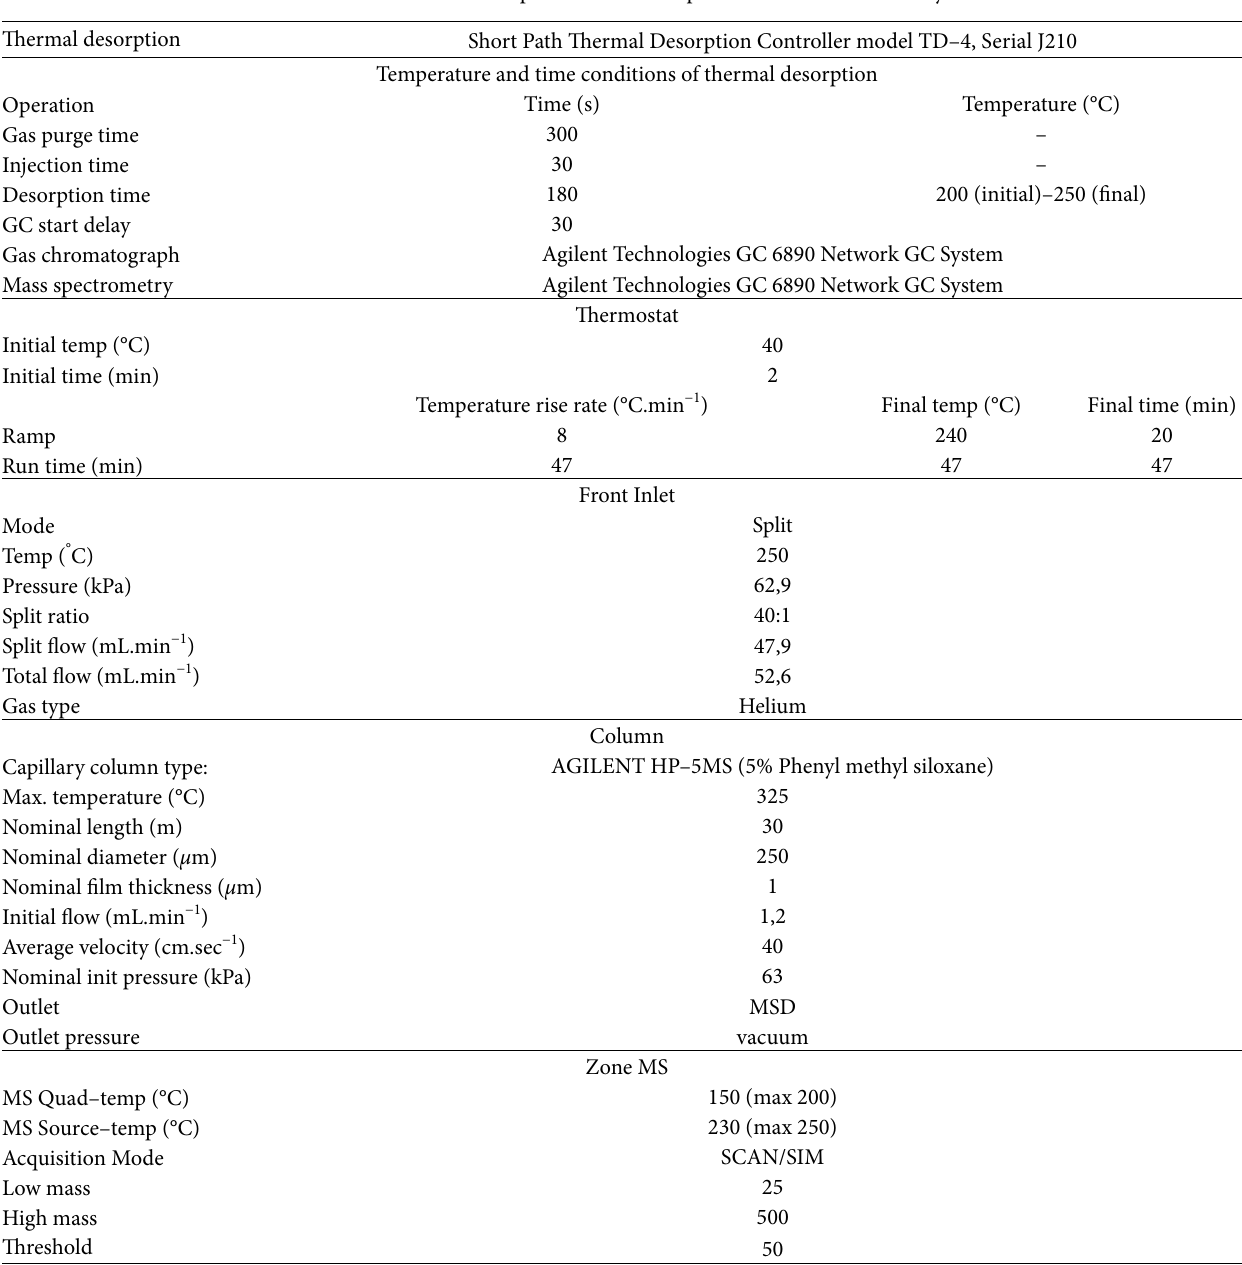
Table 2: Thermal desorption and GC-MS parameters used in the